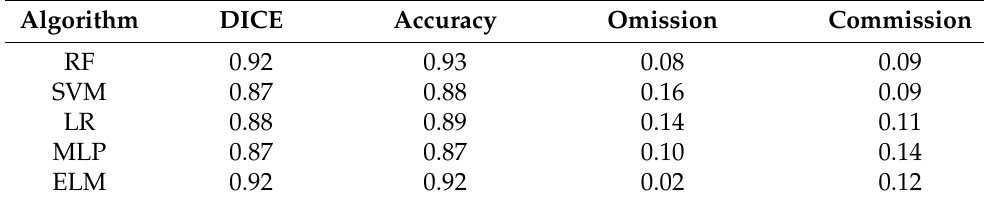
Table 3. Best model performance for the POST dataset applied over the validation set.